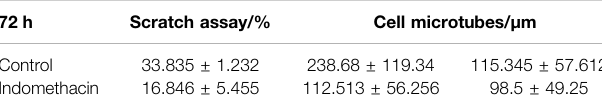
TABLE 5 | The average healing rate of 72 h scratch assay and 72 h cell migration range on microtubes in indomethacin groups. 72 h